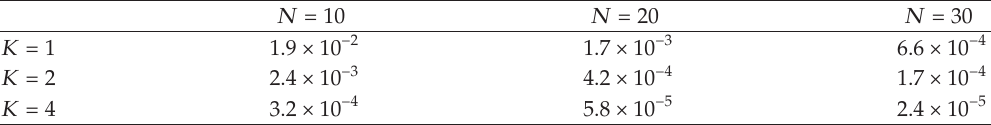
Table 9: Maximum absolute errors for a (cid:8) 0 . 1 ,b (cid:8) c (cid:8) e (cid:8) 0 . 5 ,α 1 (cid:8) 0 . 219 ,α 2 (cid:8) 1 . 965 for Example